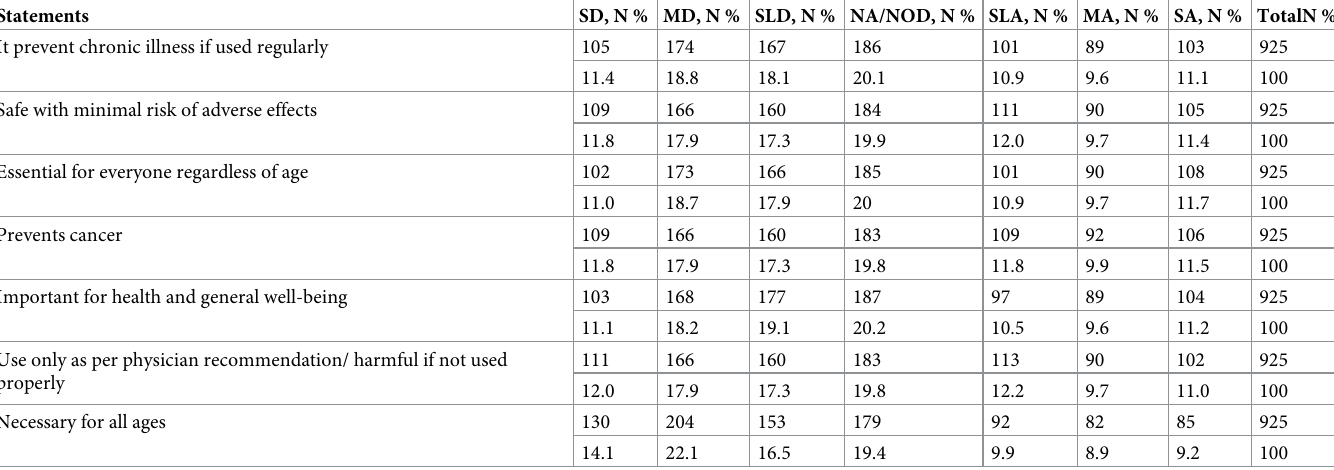
Table 7. Opinions and attitudes of pharmacy students regarding dietary supplement use.